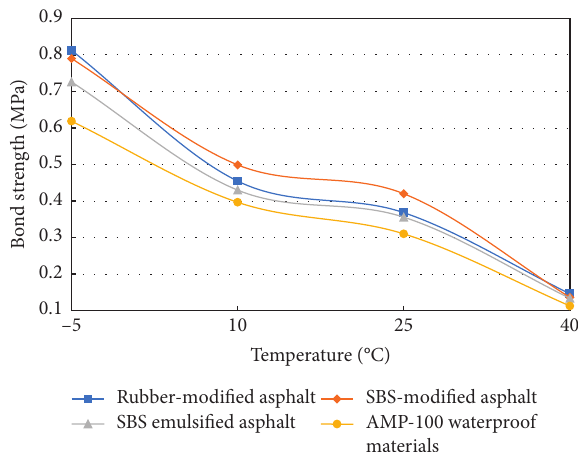
Figure 7: Bond strength of four types of waterproof adhesive layers at different